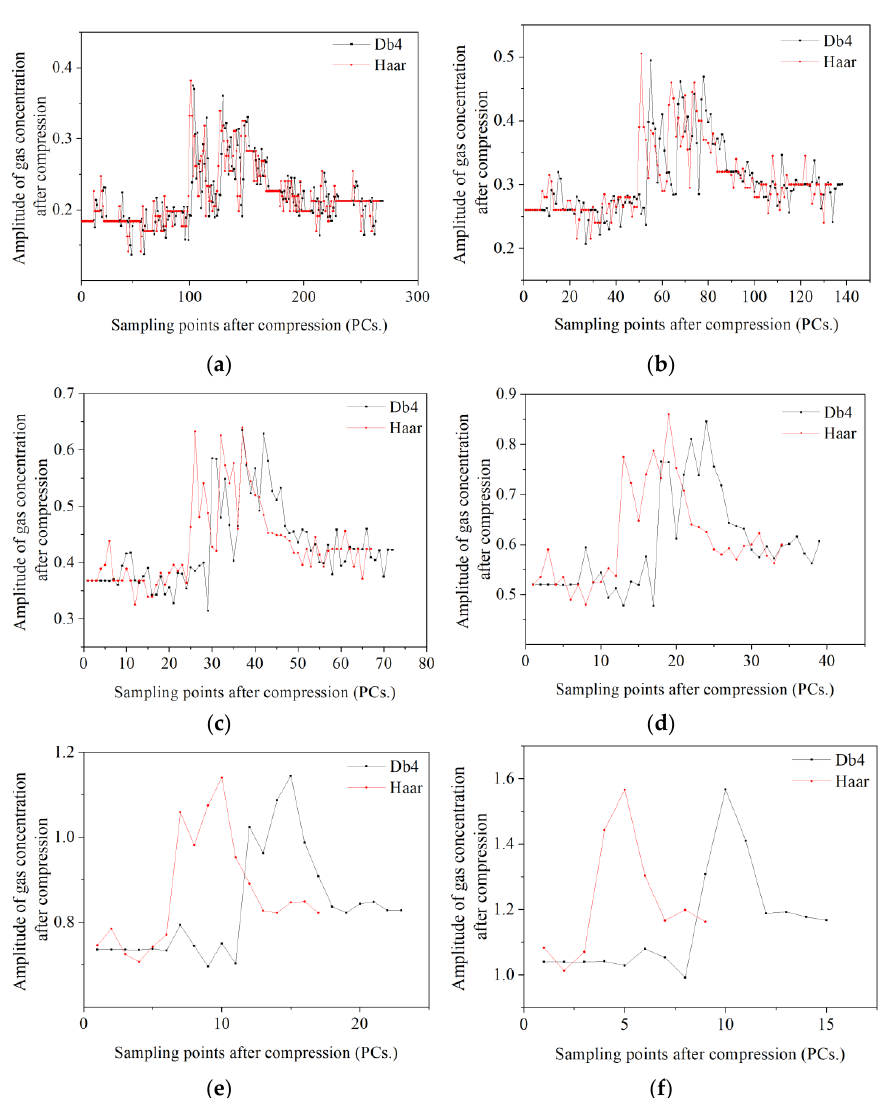
Figure 8. Multistage wavelet compression signal. ( a ) Level-1 decomposition, ( b ) Level-2 decom- position, ( c ) Level-3 decomposition, ( d ) Level-4 decomposition, ( e ) Level-5 decomposition, and ( f ) Level-6